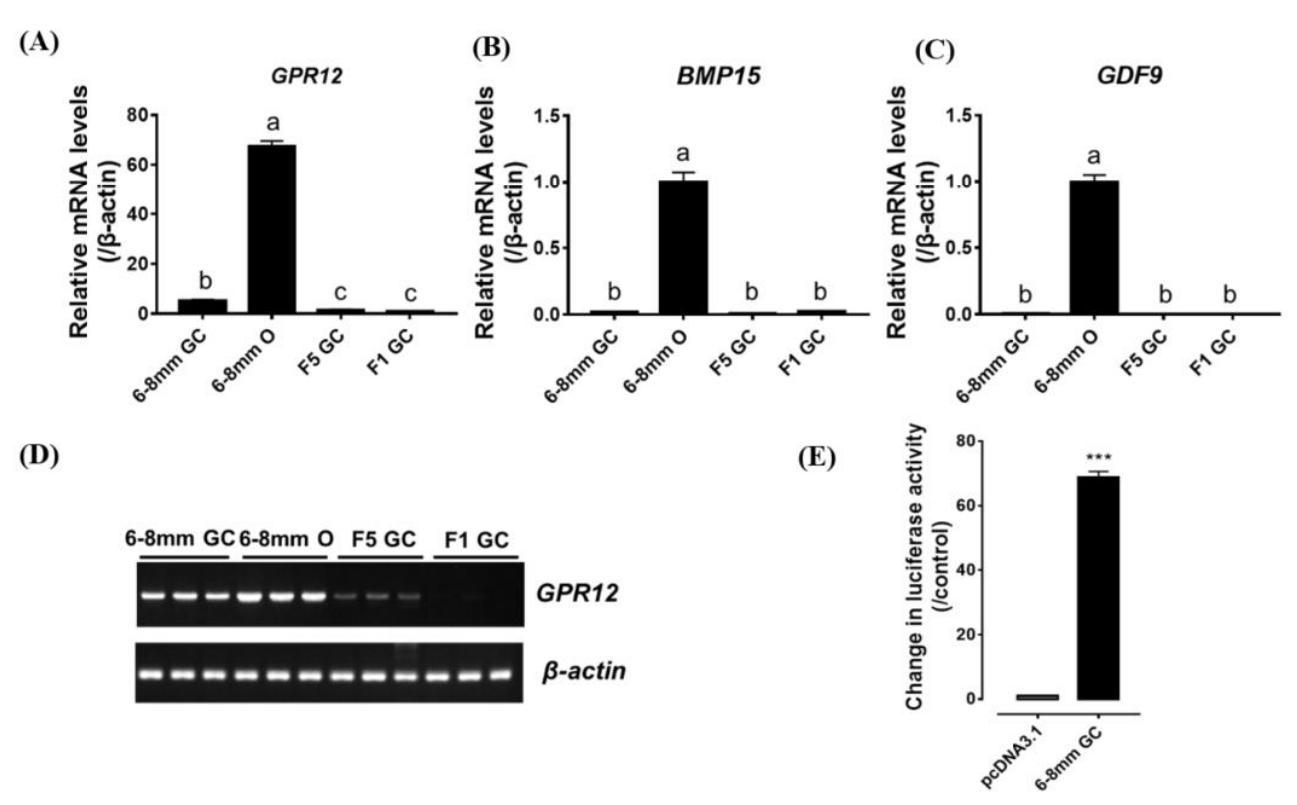
Figure 6. ( A ) qPCR of GPR12 mRNA expression in oocytes (6–8 mm Oo) of chicken 6–8 mm follicles and granulosa cells of 6–8 mm (6–8 mm GC), F5 (F5-GC) and F1 follicles (F1-GC). ( B , C ) Predominant expression of BMP15 ( B ) and GDF9 ( C ) mRNA in 6–8 mm GC, 6–8 mm Oo, F5-GC and F1-GC. In graphs A–C, different letter indicates the statical difference between two groups. ( D ) RT-PCR detection of GPR12 mRNA expressed in chicken 6–8 mm GC, 6–8 mm Oo, F5-GC, and F1-GC. The GPR12 band intensity is the strongest in 6–8 mm Oo, and its signal in GC cells decreases along follicle development. No PCR band was detected in all reverse transcription (RT)-negative controls. In graphs A–D, each data point represents the mean ± SEM of 4 replicates ( N = 4). ( E ) The constitutive activity of GPR12 in cultured 6 mm GC transfected with cGPR12 plasmid as detected by dual-luciferase reporter assay. Each data point represents the mean ± SEM of four replicates ( N = 4). *** p < 0.001 vs. control.